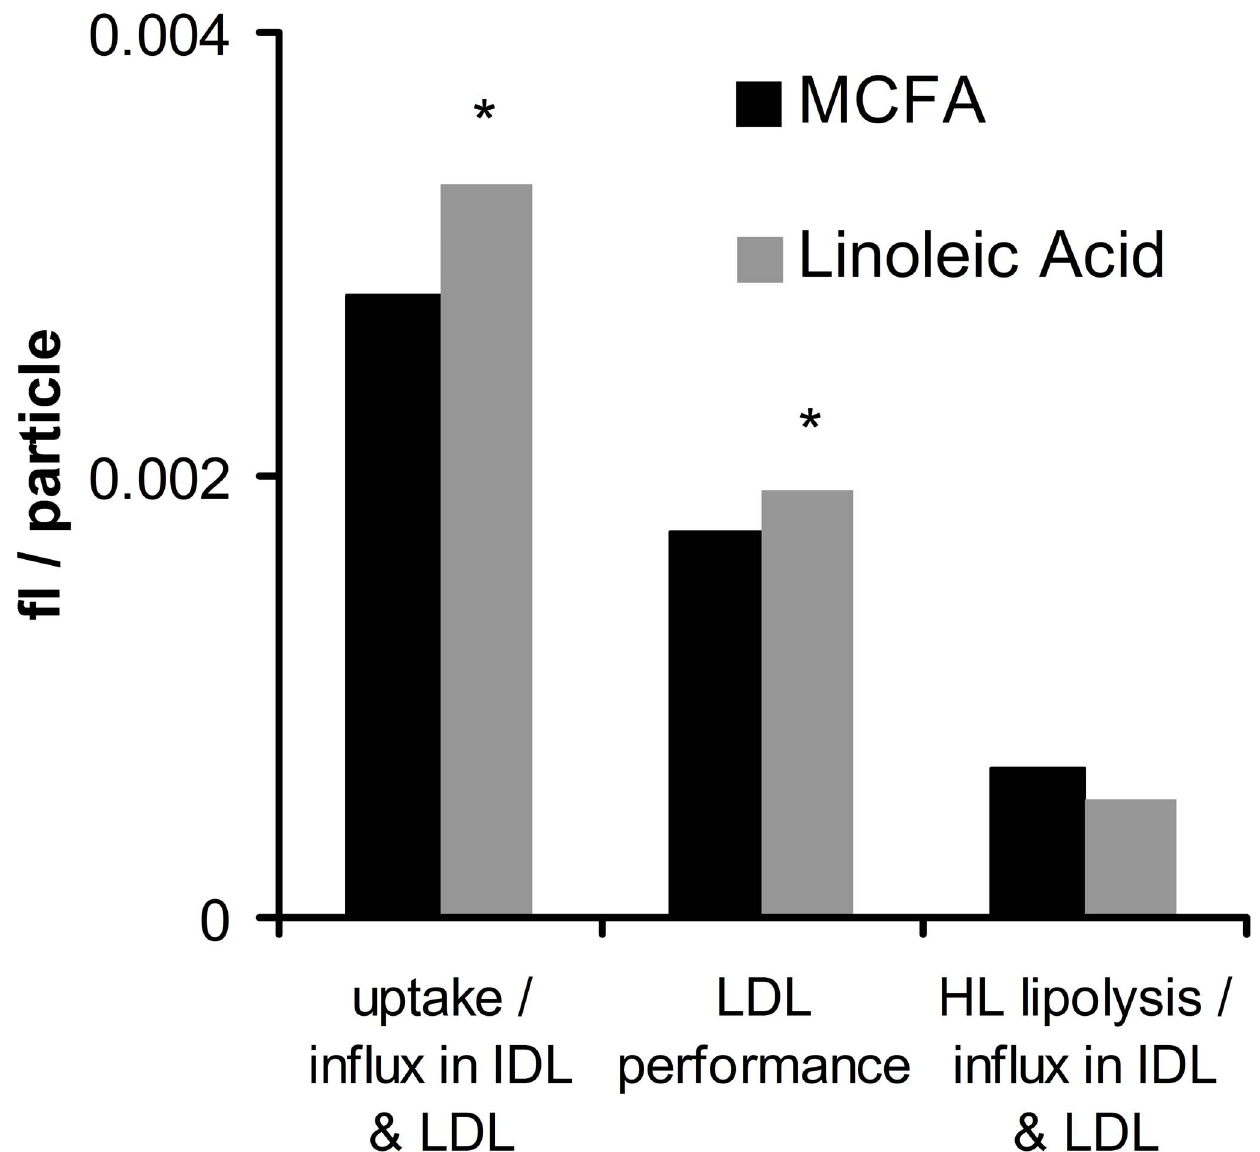
Figure 5. Ratios between average IDL and LDL metabolism parameters after dietary MCFA supplementation versus linoleic acid supplementation. LDL performance is the average of the two ratios shown to the sides. ‘‘fl/particle’’ is the unit of all three ratios. * Indicates a significant difference in two-way ANOVA between MCFA and linoleic acid supplementation, with p , 0.05. p-values of the significant measures are: uptake/influx in IDL and LDL (p=0.011); LDL performance